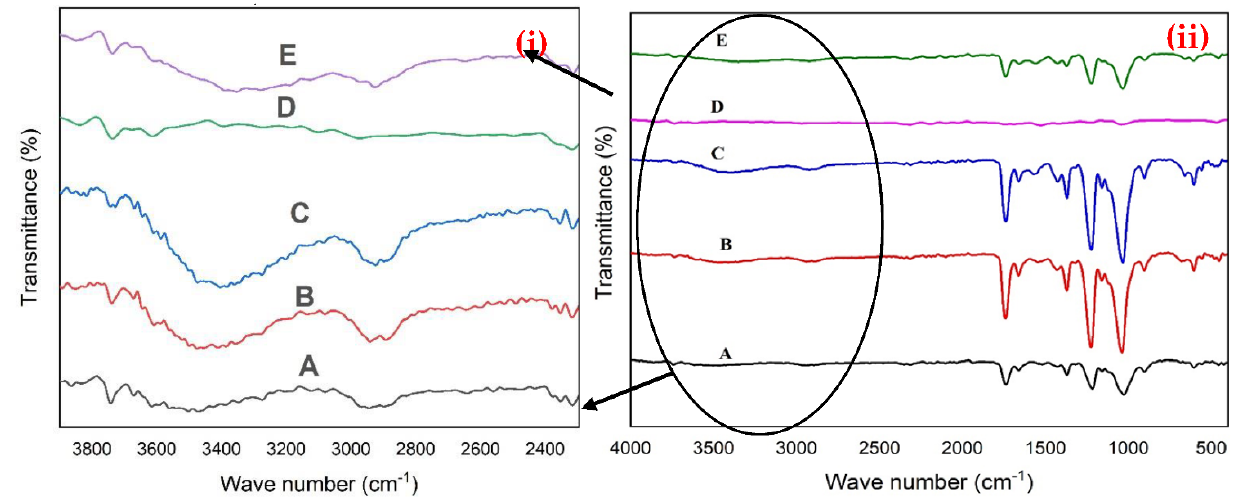
Figure 2. FTIR of CA with different additives of nanoparticles; (A) CA, (B) Sm 2 O 3 @CA, (C) MgO@CA, (D) Sm 2 O 3 /MgO@CA, and (E) Sm 2 O 3 /MgO/GO@CA. ( i ) FTIR spectra of the range 2400–4000 cm − 1 , while ( ii ) represents the whole spectra from 400–4000 cm − 1 . Table 1. FT-IR bands (in cm − 1 ) of CA films with different additives of nanocomposites. CA Sm 2 O 3 @CA MgO@CA Sm 2 O 3 /MgO@CA Sm 2 O 3 /MgO/GO@CA Assignment Ref.